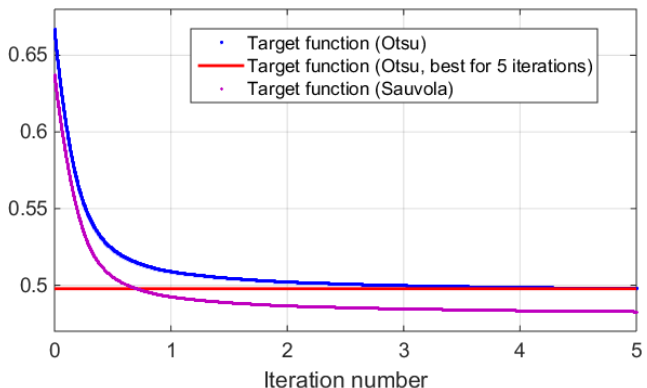
Figure 8. Dependency of target function vs. iteration number during DSRT stage of hologram